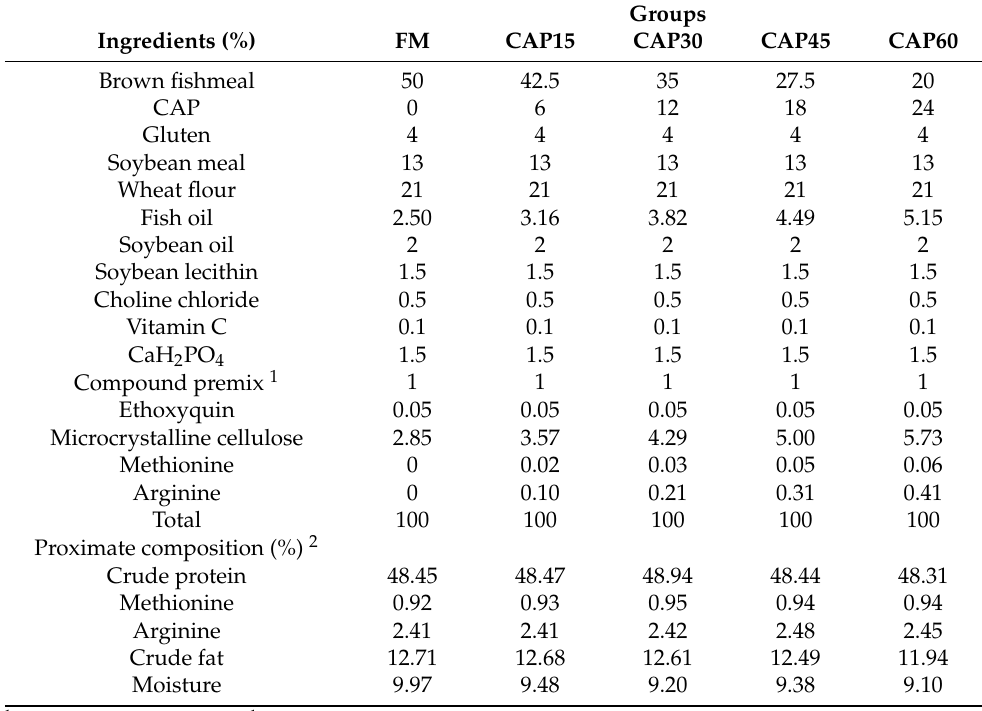
Table 1. Ingredient composition and nutrient content of experimental diets (dry matter